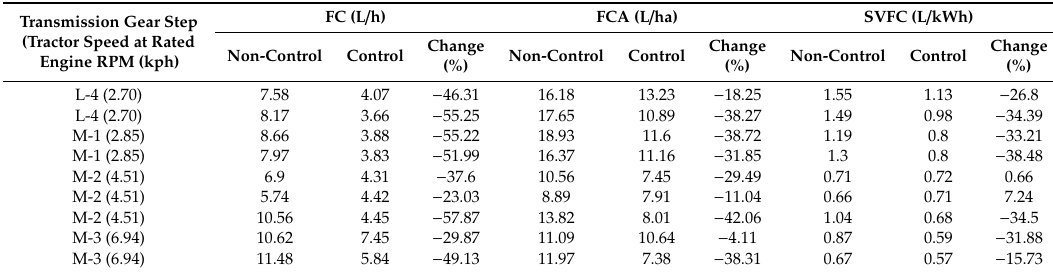
Table 5. Fuel e ffi ciency parameter results of plowing